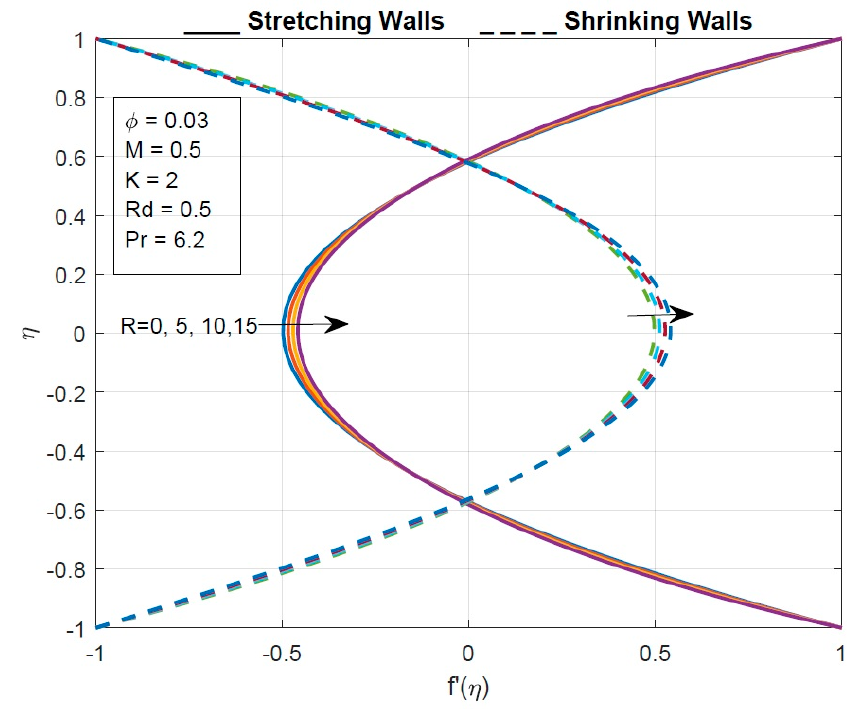
Figure 9. T he effect of the Reynolds number on the velocity profile.